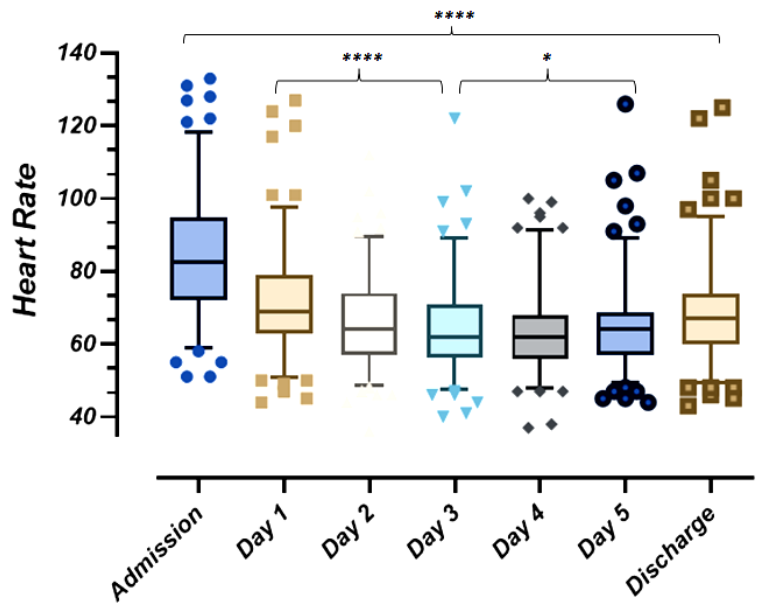
Figure 4. Box plot showing heart rate changes in course of Remdesivir administration on a subset of 133 patients.* p < 0.05; **** p < 0.001. 133 patients.* p < 0.05; **** p <